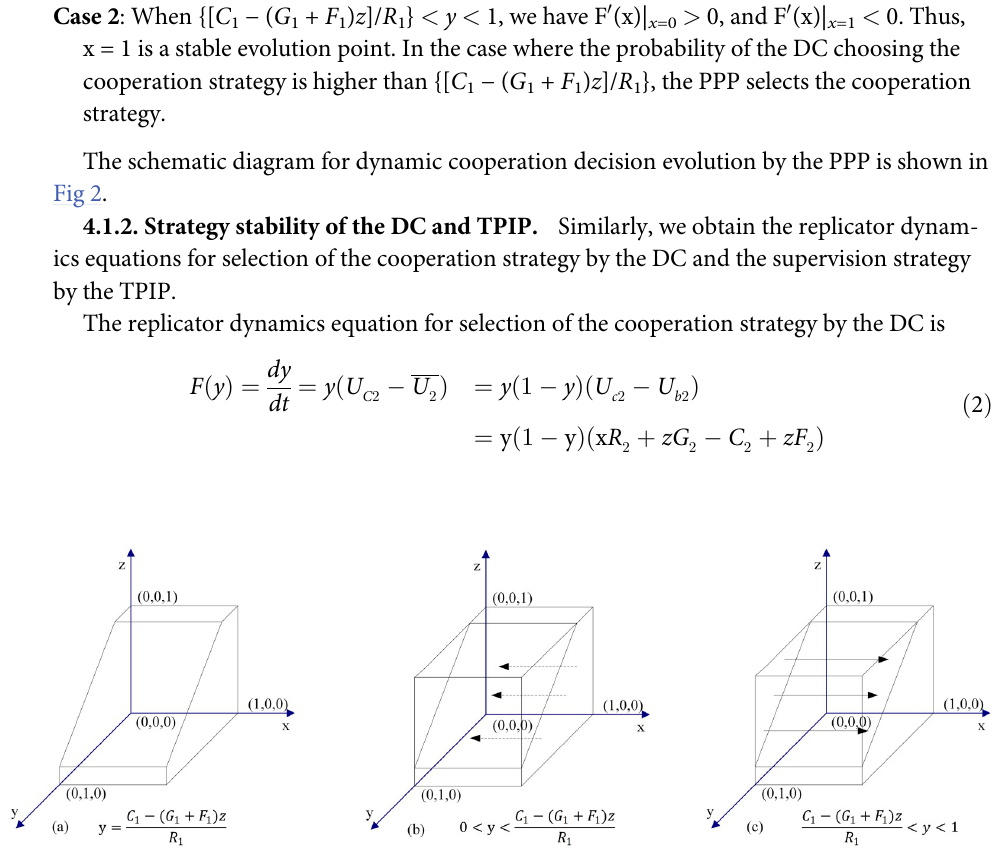
Fig 2. Dynamic evolution chart of PPPs’